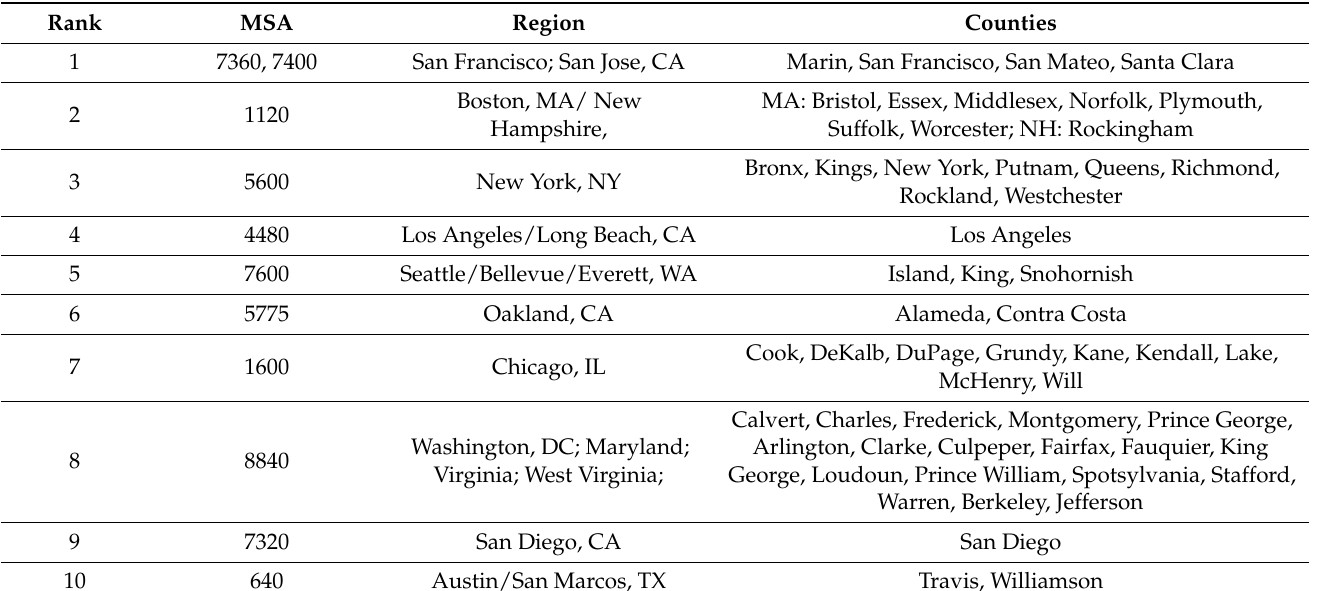
Table 1. Top venture capital MSA (Metropolitan Statistical Areas) codes by investment dollars. Following table lists top MSAs based on data by the National Venture Capital Association (NVCA) on startup funding